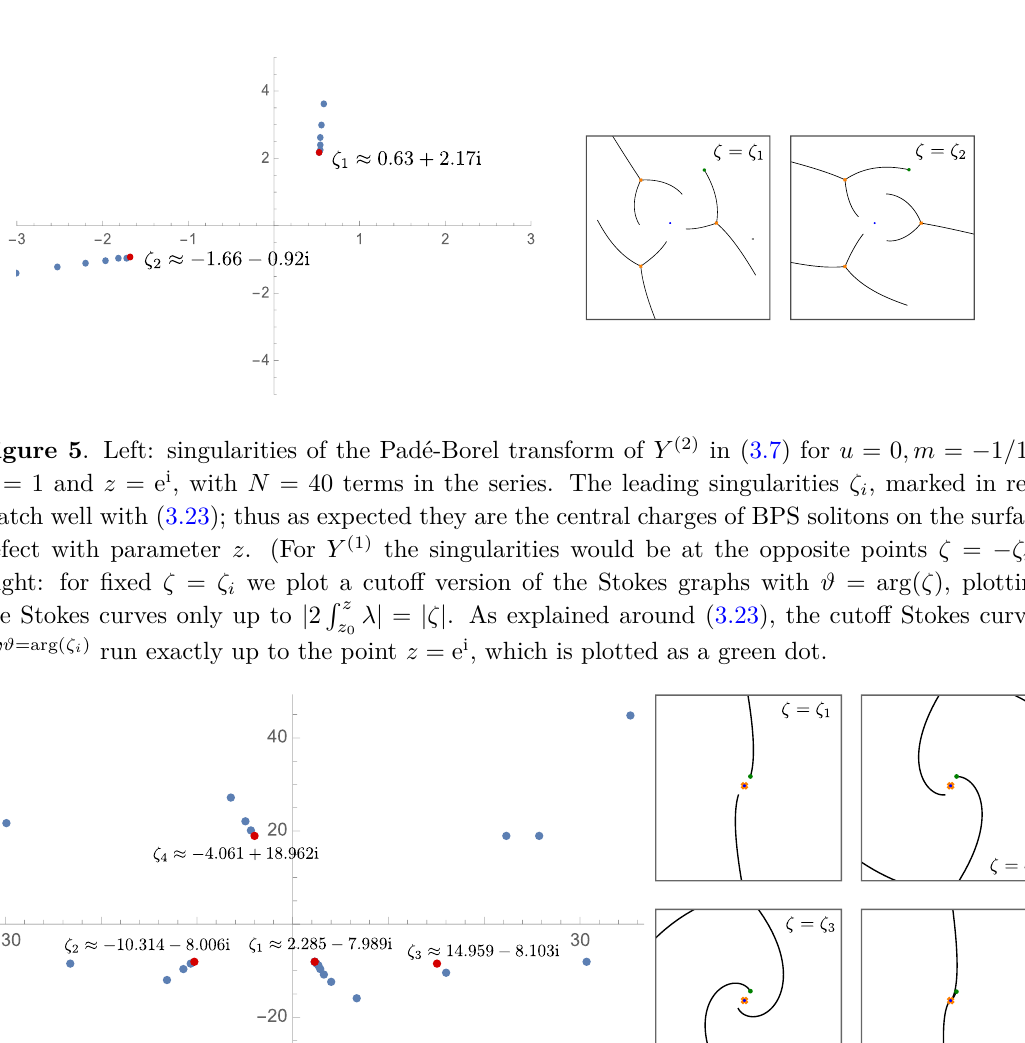
Figure 6 . Left: singularities of Padé-Borel transform of Y (2) in (3.7) for u = 2 , m = 0 , Λ = 1 / 5 and z = e i , with N = 50 terms in the series. There are infinitely many poles of ˆ Y (2) , corresponding to the central charges of solitons supported at z . Only finitely many of them are visible in our approximation. (Again, for Y (1) the singularities would be at the opposite points ζ = − ζ .) Right: i cutoff Stokes graphs at ζ = ζ , as in figure 5 1 , ζ 2 , ζ 3 , ζ 4